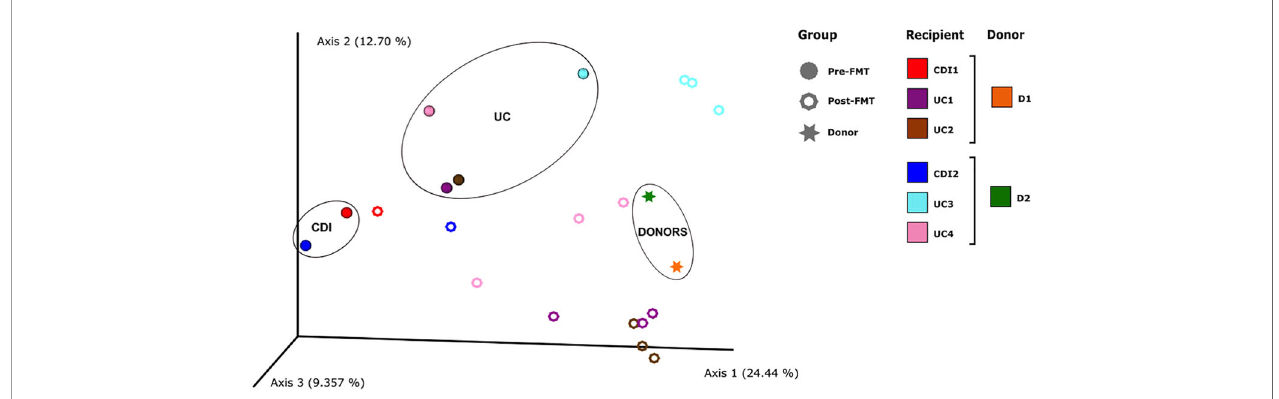
FIGURE 5 | PCoA based on unweighted UniFrac distances calculated from the microbiological pro fi les of stool samples. Each point represents a sample, color indicates each subject, and the shape indicates if a sample was obtained before or after fecal microbiota transplantation (FMT), or whether it comes from a donor. In addition, brackets indicate which donor were selected for each patient.